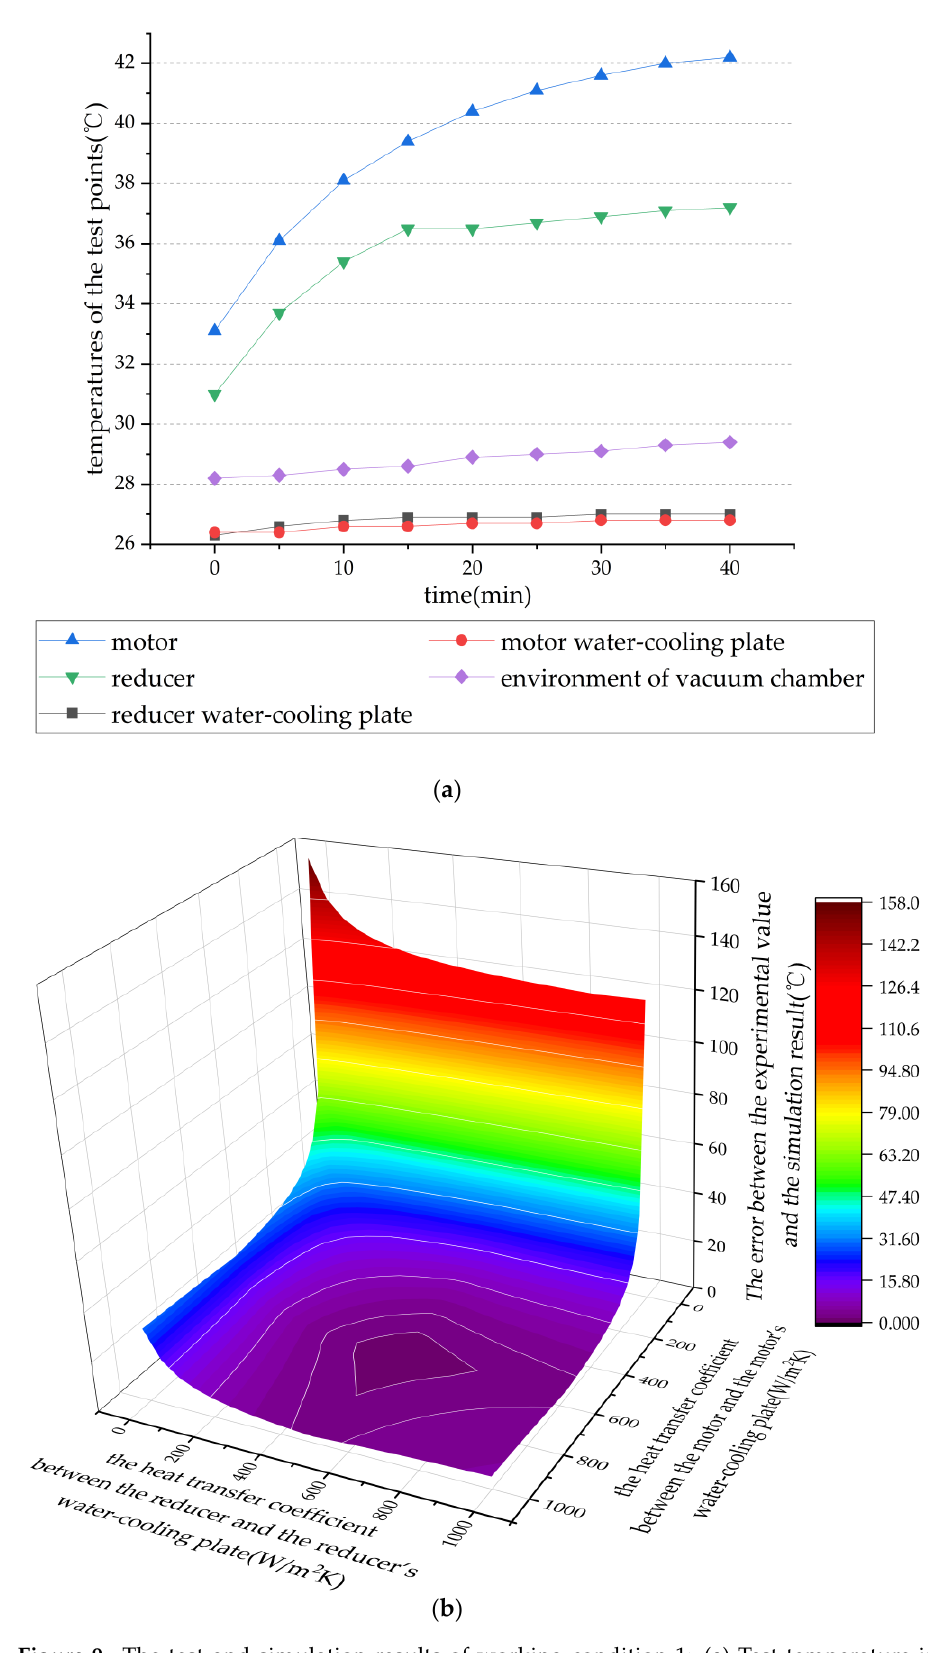
Figure 9. The test and simulation results of working condition 1 : ( a ) Test temperature increase diagram; ( b ) The parameterized simulation results of working condition 1.